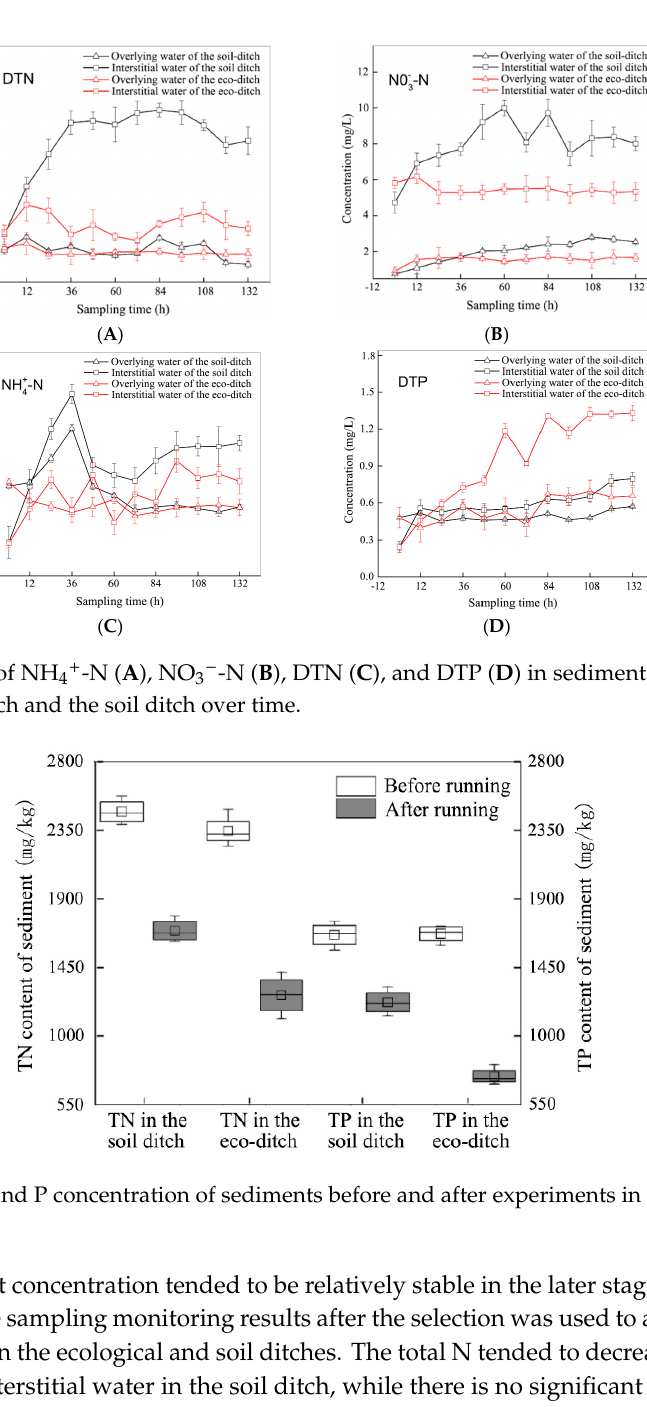
Figure 5. Changes of NH 4+ -N ( A ), NO 3 − -N ( B ), DTN ( C ), and DTP ( D ) in sediments and overlying water of the eco-ditch and the soil ditch over time.